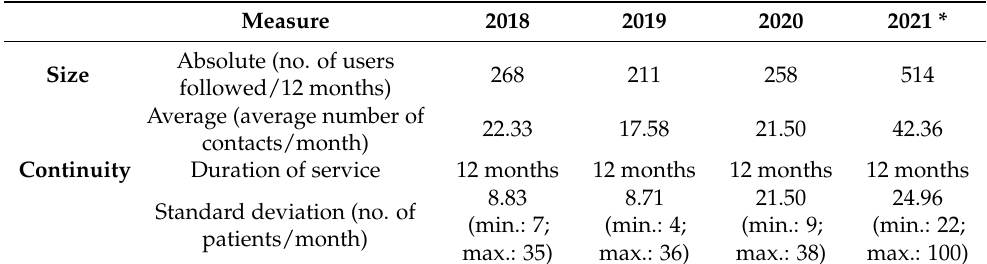
Table 1. Performance measures of the WIN4ASD web app (* data on 2021 refers to January–Novem- ber).